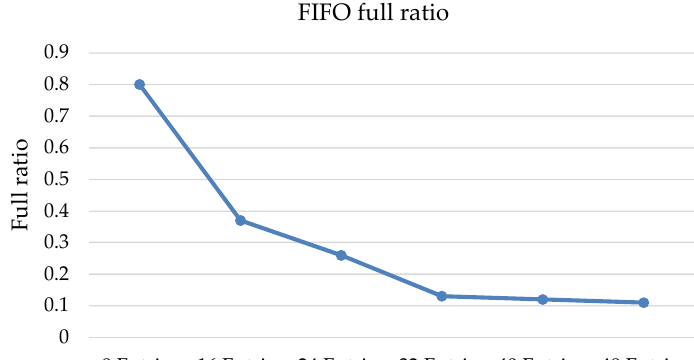
Figure 9. Performance analysis results of an instruction control FIFO.